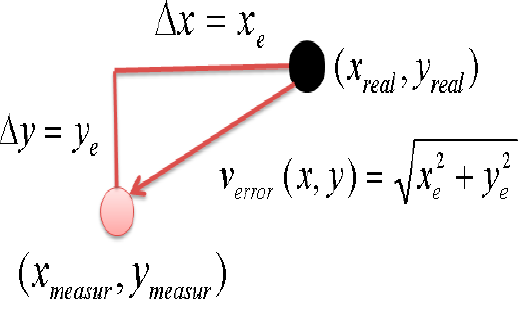
Figure 15. Position error estimate.